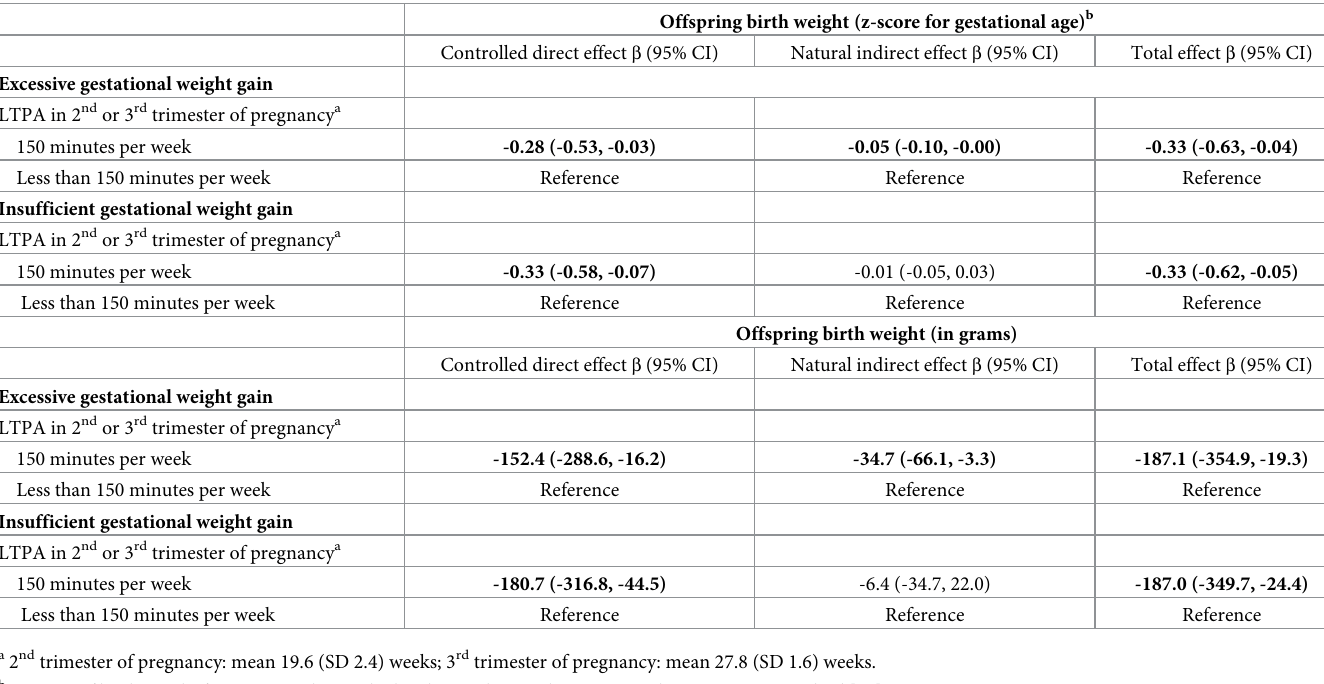
Table 3. Estimates of direct effect and effect mediated through excessive and insufficient gestational weight gain of the association between leisure-time physical activity (LTPA) and offspring birth weight in the MINA-Brazil cohort